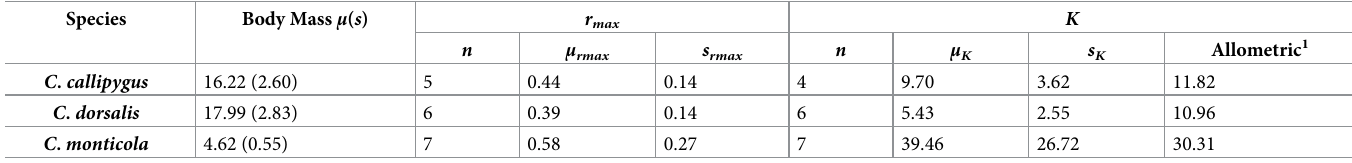
Table 1. Estimates of population parameters r and K for Peters’ duiker C . callipygus , bay duiker C . dorsalis and blue duiker C . monticola . max Species Body Mass μ ( s ) r max K μ rmax s K Allometric 1